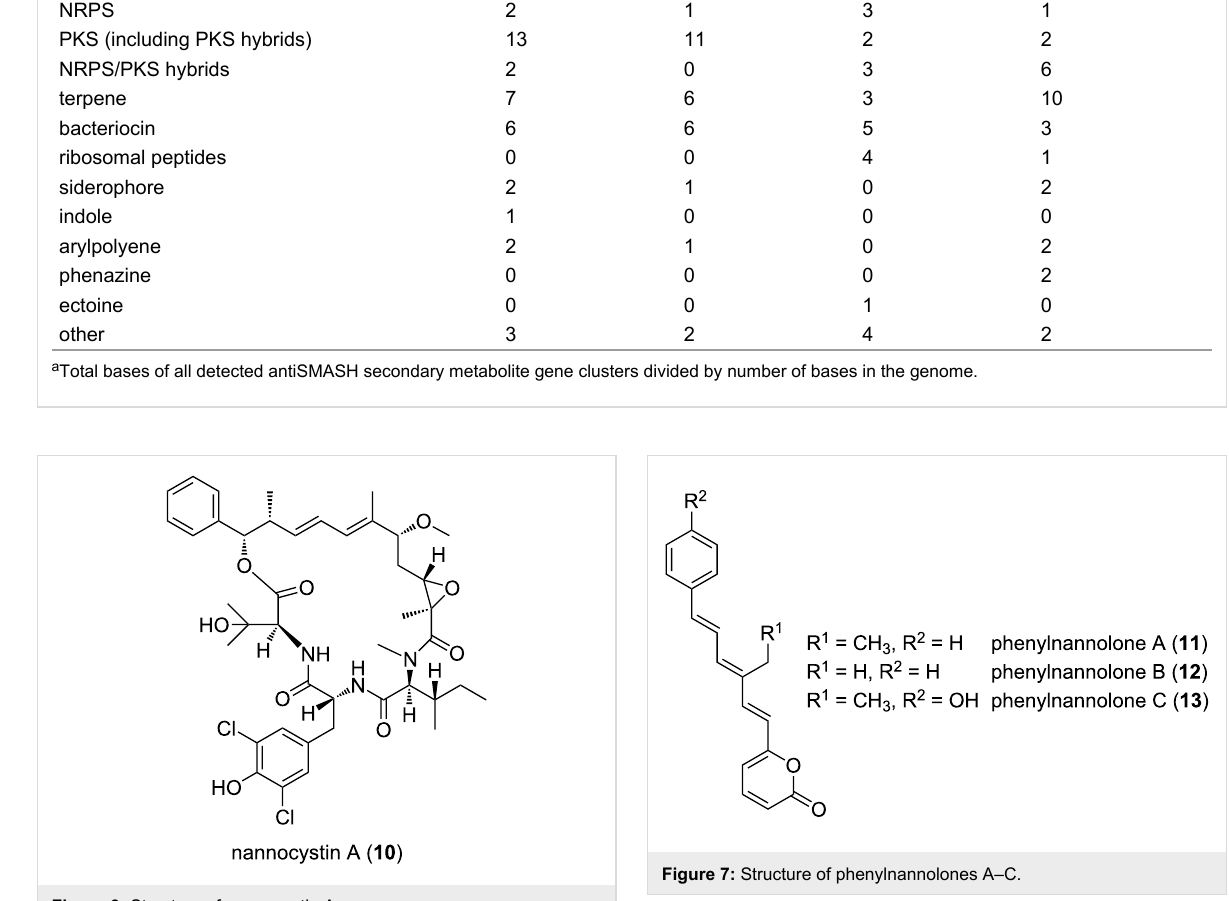
Figure 6: Structure of nannocystin A.